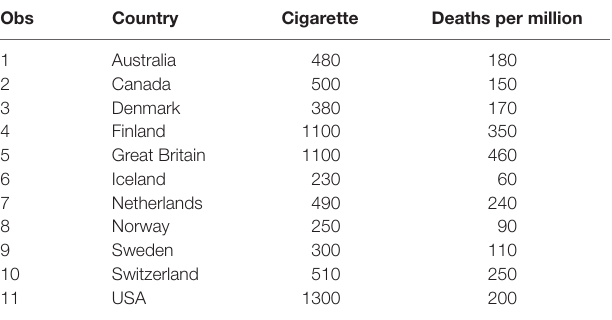
TABLe 1 | The death rate and cigarette data in Freedman et al. 1